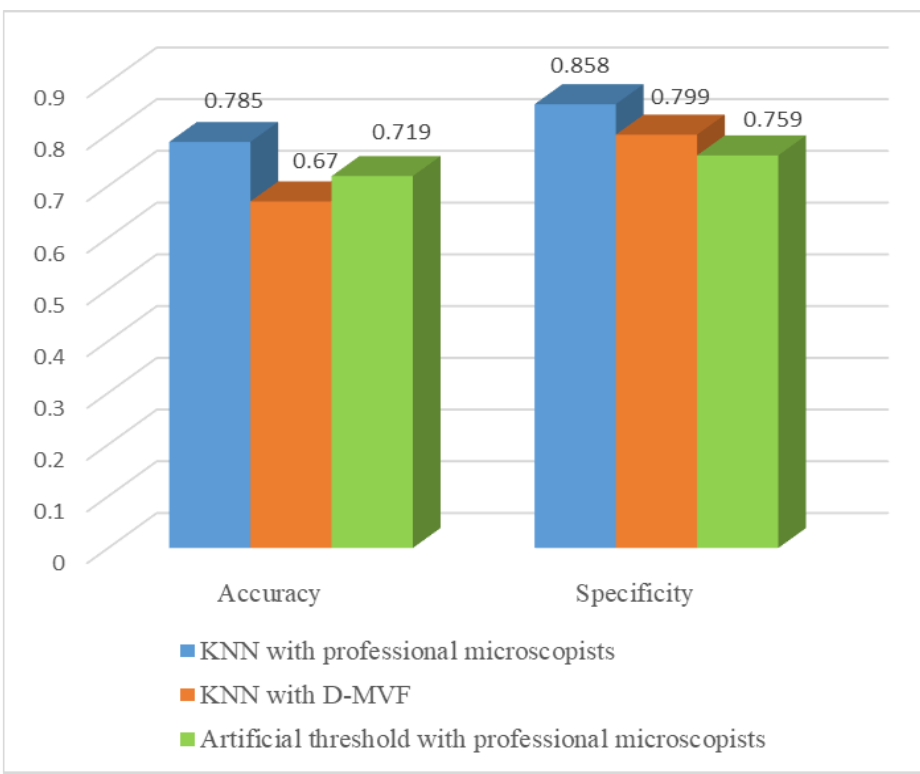
Figure 10. The accuracy and specificity of KNN and artificial thresholds in DN diagnosis. The comparison of the blue column and green column in Figure 10 points out that